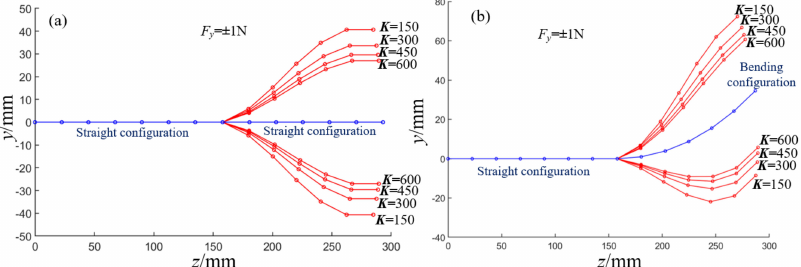
Figure 16. The equilibrium conformations of the distal segment under different spring stiffness. ( a ) The equilibrium conformations of the distal segment in initial configuration. ( b ) The equilibrium conformations of the distal segment in bending